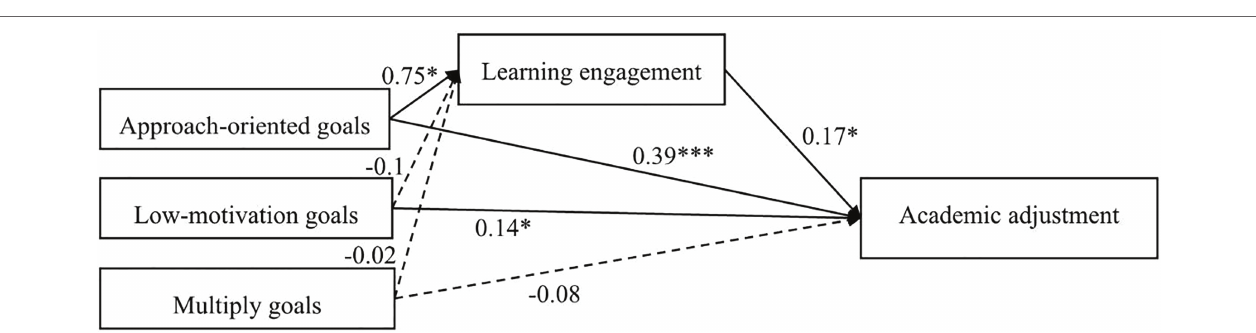
FIGURE 3 | The proposed mediated model on individual level. * p < 0.05, *** p <